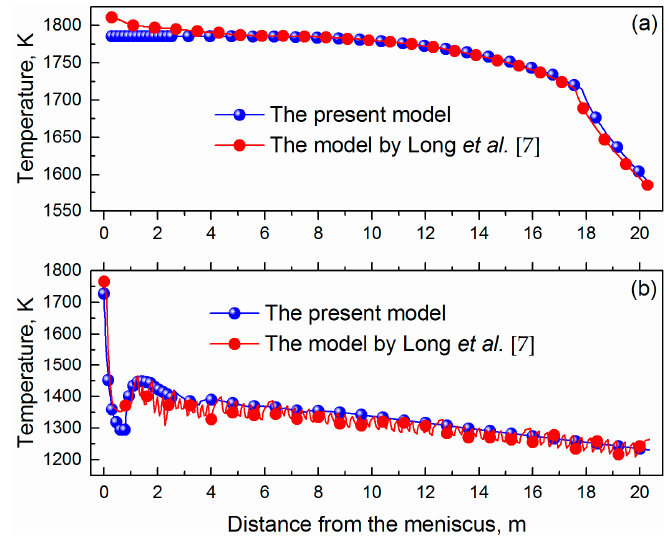
Figure 7. ( a ) Slab center and ( b ) wide surface center temperature along the casting direction.